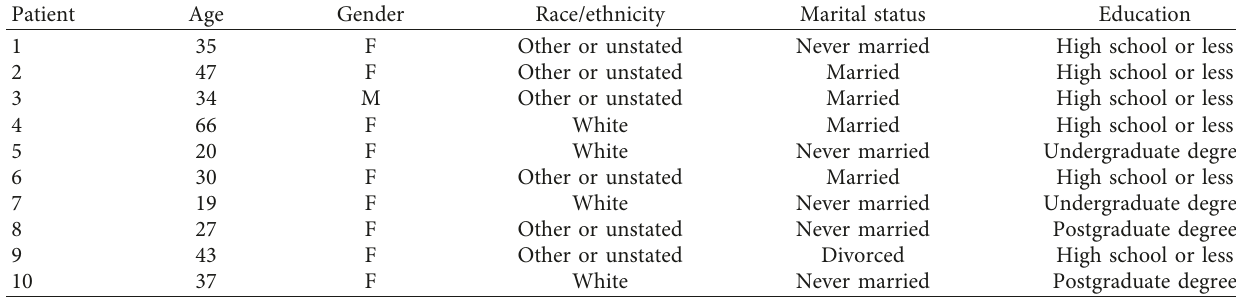
Table 1: Demographic characteristics of